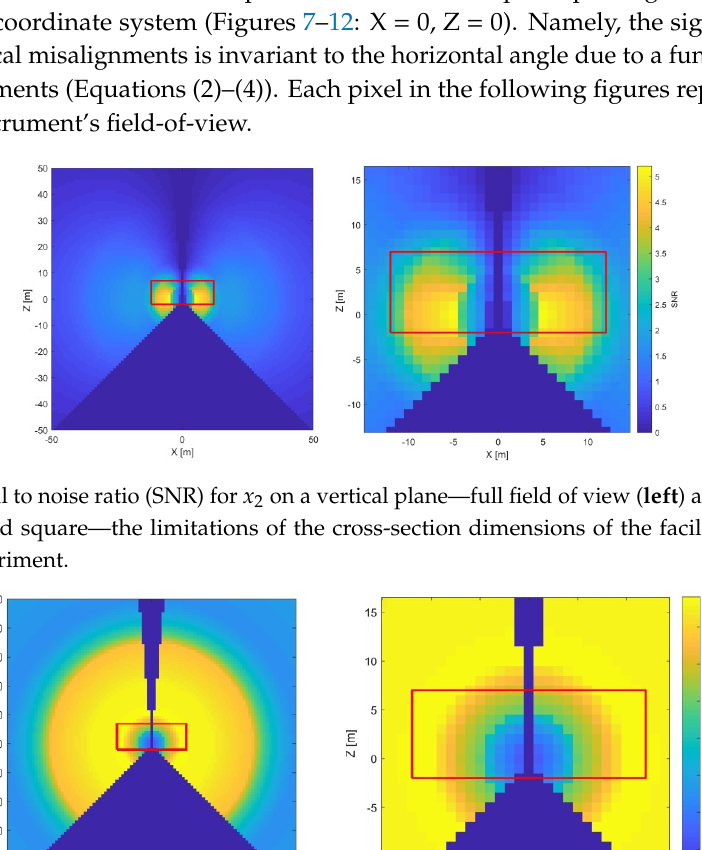
Figure 8. SNR for x 4 in a vertical plane—full field of view ( left ) and the close-up ( right Figure 8 . SNR for 𝑥 (cid:2872) in a vertical plane—full field of view (left) and the close-up (right).